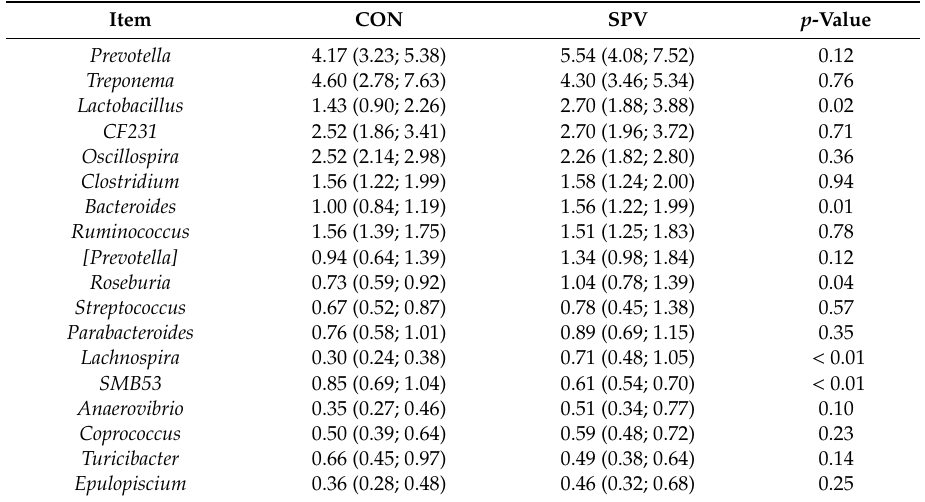
Table 7. The e ff ect of sweet potato vine treatment on the relative abundances of eighteen genera (%, > 0.3% of total abundances) in Meishan